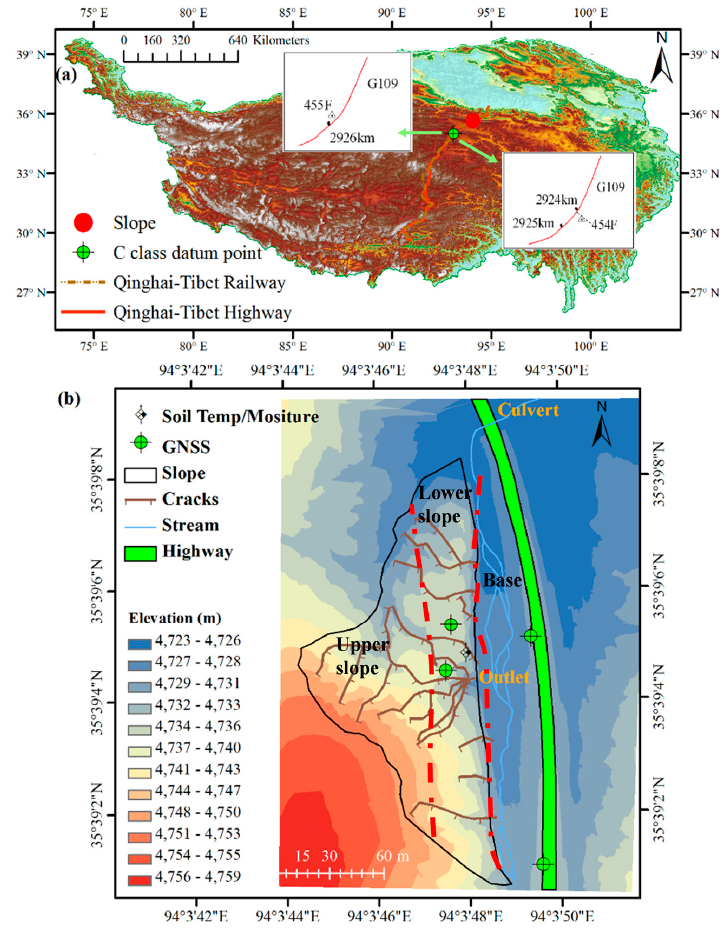
Figure 1. Map of the slope in the permafrost: ( a ) Map showing the location of the slope in permafrost; and ( b ) elevation map of the slope (data from unmanned aerial vehicle: DJI Inspire 1). The two red dotted lines divide the slope into three zones: the upper slope (left), the lower slope (center), and the base of the slope (right).